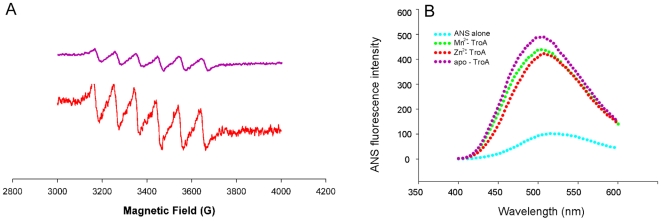
X-band EPR spectra and ANS fluorescence analysis of SsTroA.(A) EPR spectra of Mn2+ (100 µM) in the absence (red line) and presence (purple line) of SsTroA (100 µM) at room temperature in solution. The total Mn2+ concentration was the same in both samples. The signal intensity decrease corresponds to the zero-field splitting arising from the disturbances in the octahedral ligand field of the bound metal. The instrument conditions are as follows: microwave power, 20 mW; microwave frequency, 9.53 GHz; modulation frequency, 100 KHz; modulation amplitude, 1 G; and modulation amplitude, 1.0 mT. (B) Fluorescence changes in the intensity emission for SsTroA indicate a metal dependent decrease in hydrophobic residue exposure. Emission spectra of ANS in the presence of different SsTroA states: apo-SsTroA (purple), Zn2+-SsTroA (green) and Mn2+-SsTroA (red). A significant enhancement in fluorescence is probed on binding of ANS to apo-SsTroA. This fluorescence is slightly diminished in the presence of metal ions, which indicates the ordering of the metal binding domain of the SsTroA structure when metal is bound.